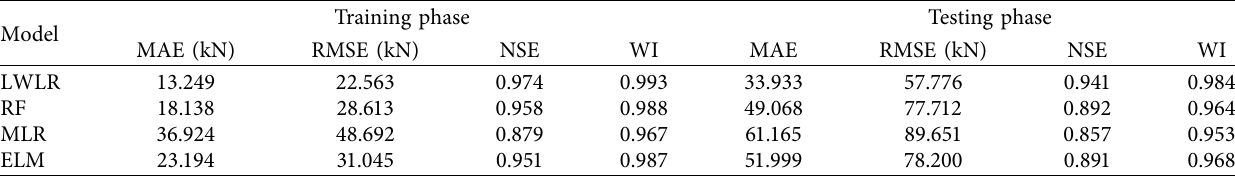
Table 5: A comparison between the efficiency of the proposed models. Model